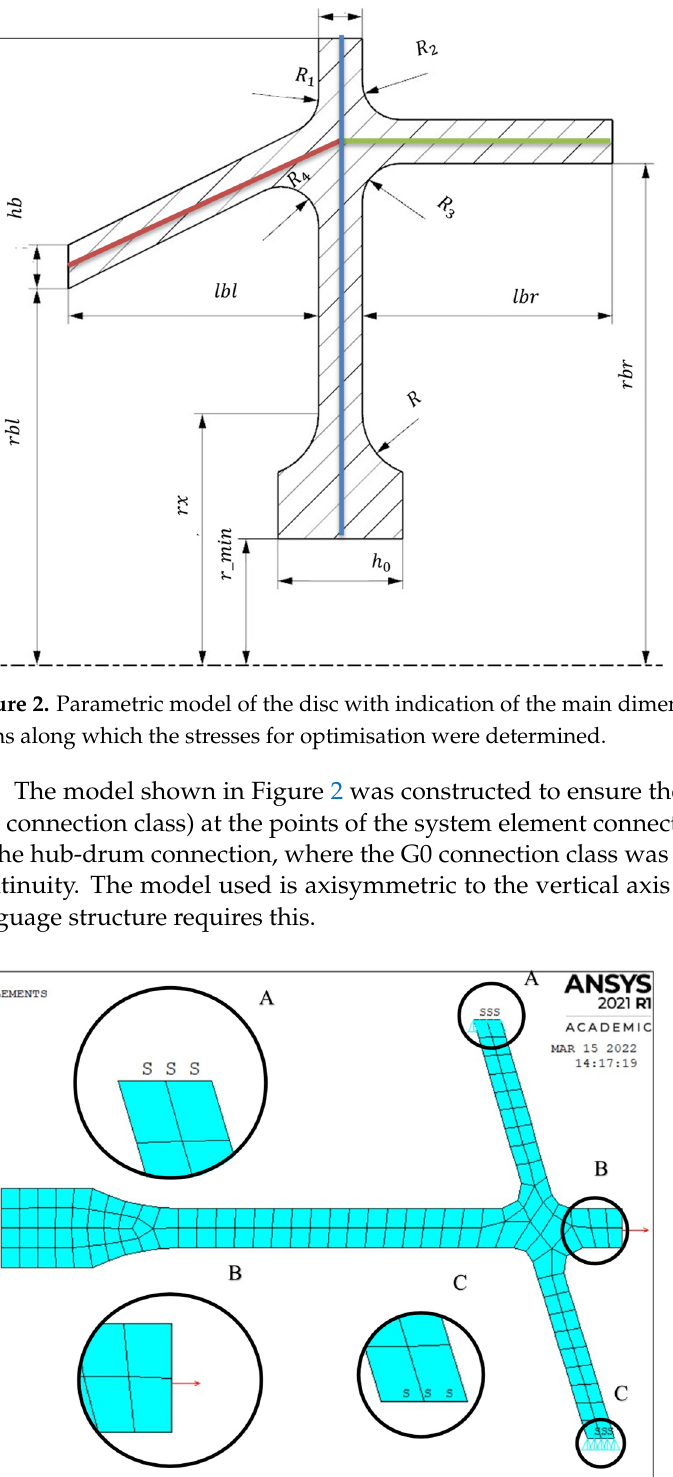
Figure 1. Optimised compressor disc: ( a ) real object, ( b ) CAD model.